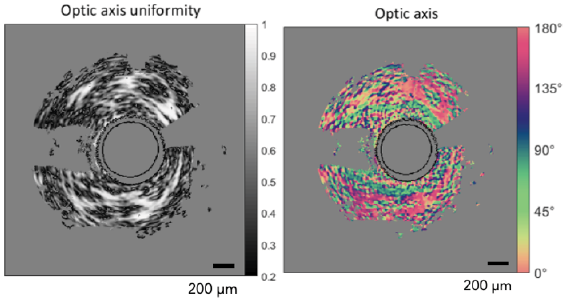
Fig. 3. Cross section frame from a proximal location along the pullback. OAxU B-scan and corresponding OA image.